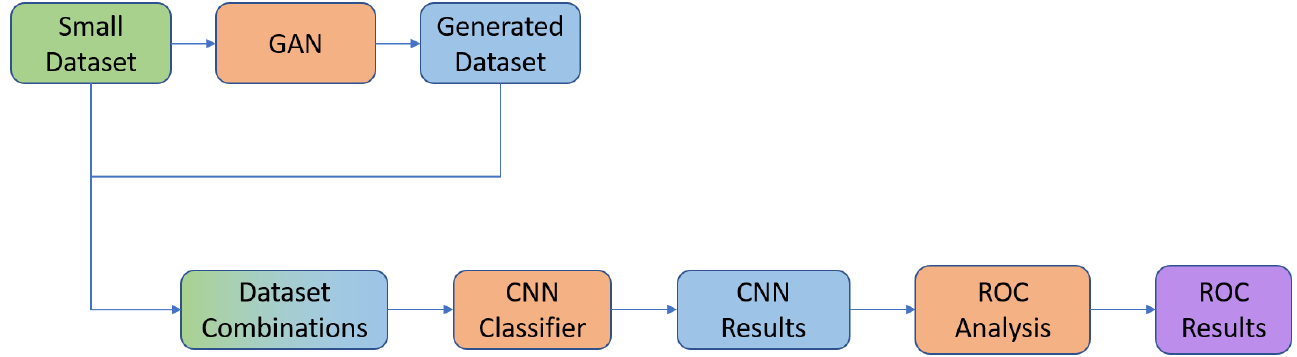
Figure 1. Proposed Automatic Target Recognition (ATR)